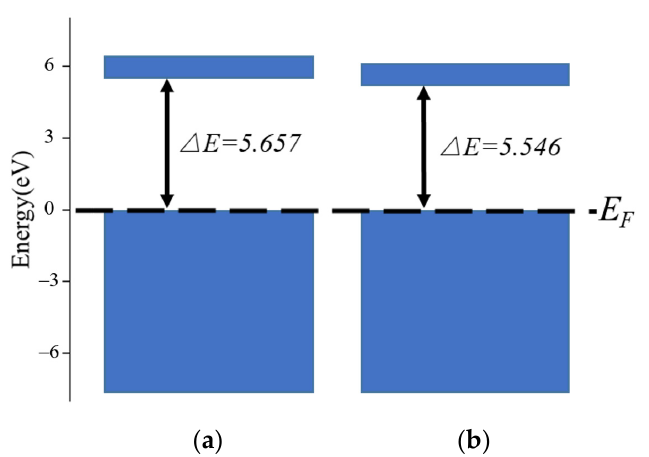
Figure 18. The band structure of two cellulose polymer insulation models: ( a ) Cellulose model; ( b ) Cellulose model with 3.5% water. ( b ) Cellulose model with 3.5%